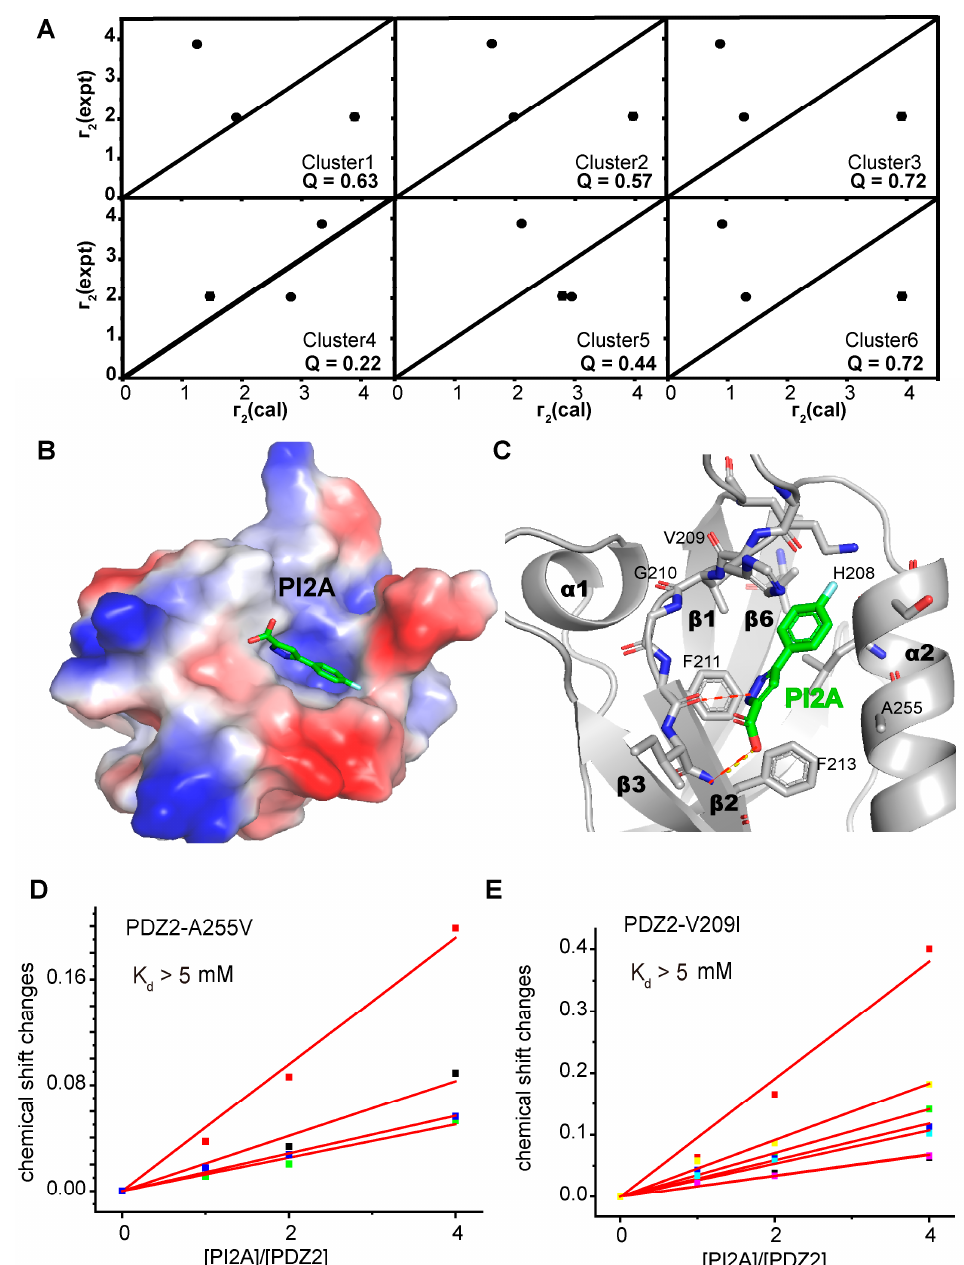
Figure 3. Binding modes of PI2A for MDA-9 PDZ2 domain. ( A ) Correlations between the experimental and back-calculated PRE values for the lowest energy pose within each cluster. The Q values for each pose are annotated. The black solid squares indicate the experimental and back-calculated PRE values for each H atom of PI2A and annotated with experimental errors. ( B ) The lowest energy binding pose of the PI2A and MDA-9 PDZ2 domain in cluster 4. The electrostatic surface of MDA-9 PDZ2 domain is represented. PI2A is in a green stick representation. ( C ) Detailed interactions between PI2A and conserved residues within 5Å of MDA-9 PDZ2 domain. ( D , E ) Binding affinities of PI2A to the A255V or V209I mutant of MDA-9 PDZ2 domain can be best-fitted from the dose-dependent titration curves (red solid lines) for the disturbed residues simultaneously. Fitting multiple titration curves simultaneously provides a more accurate estimate of K d . The different colored squares in ( D , E ) represent the chemical shift changes for each residue at different concentrations. Chemical shift changes were calculated as [( Δδ H ) 2 + ( Δδ N /5) 2 ] 1/2 , where Δδ H and Δδ N denote the chemical shift changes for 1 H and 15 N, respectively.